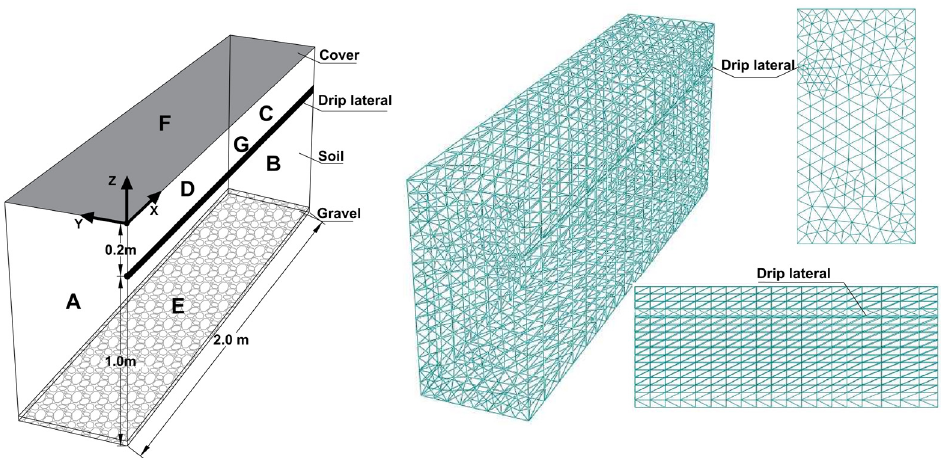
Figure 4. Finite element representation of the soil box and schematization of the lateral.